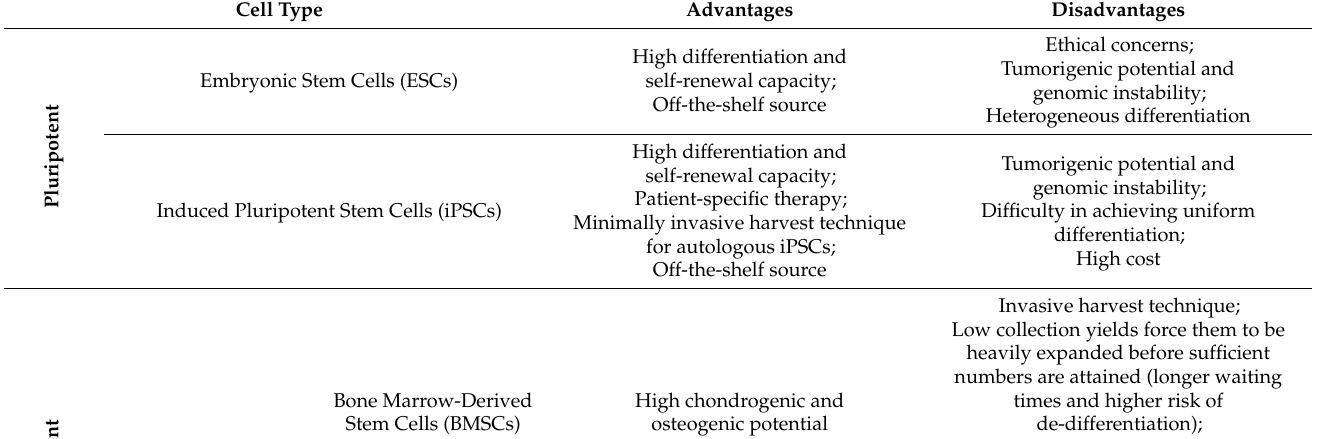
Table 2. Summary of the main cell types used for OCTE, with their advantages and disadvantages.